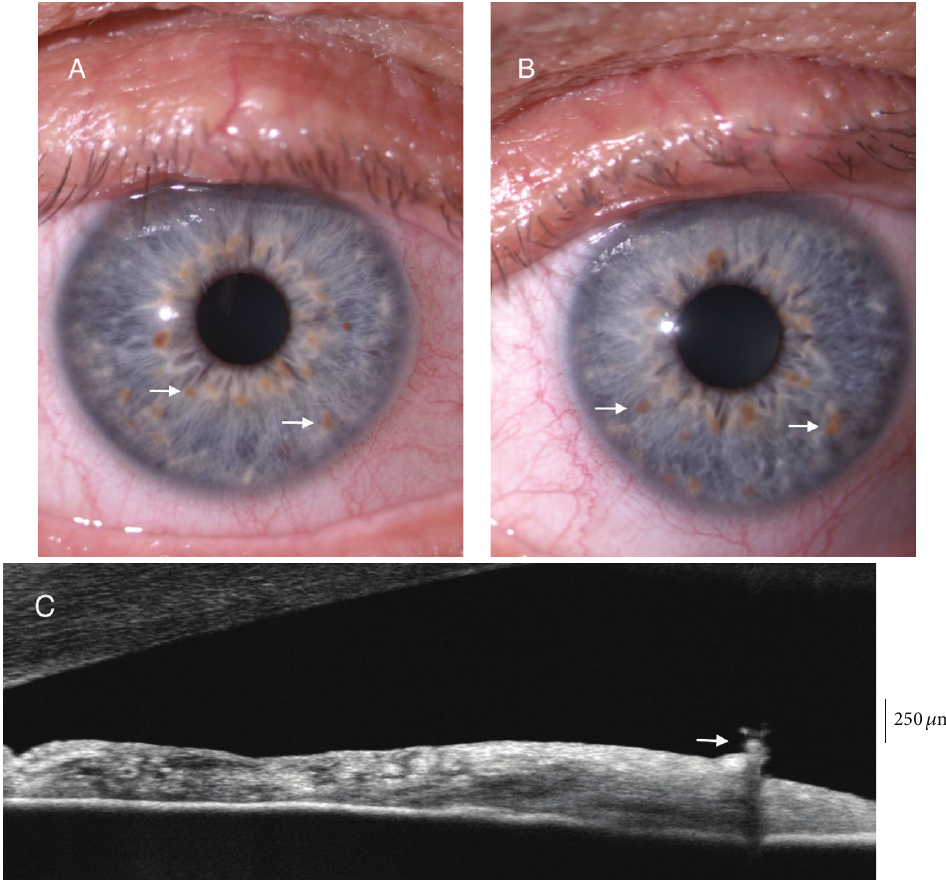
Figure 2: Lisch nodules in neurofibromatosis type 1. Slit lamp (A, B) and anterior segment optical coherence tomography images (C), arrows indicate Lisch nodules.